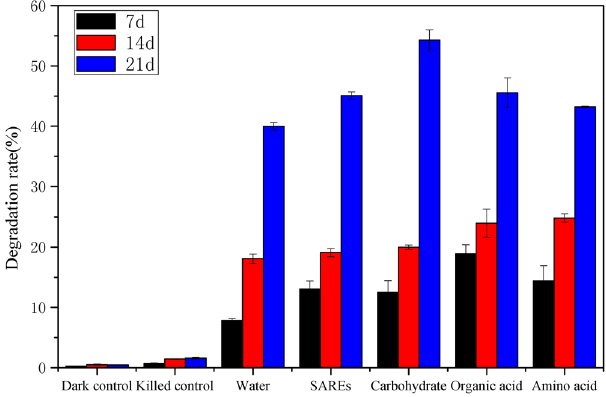
Figure 1. Effect of root exudate components on the degradation rate of